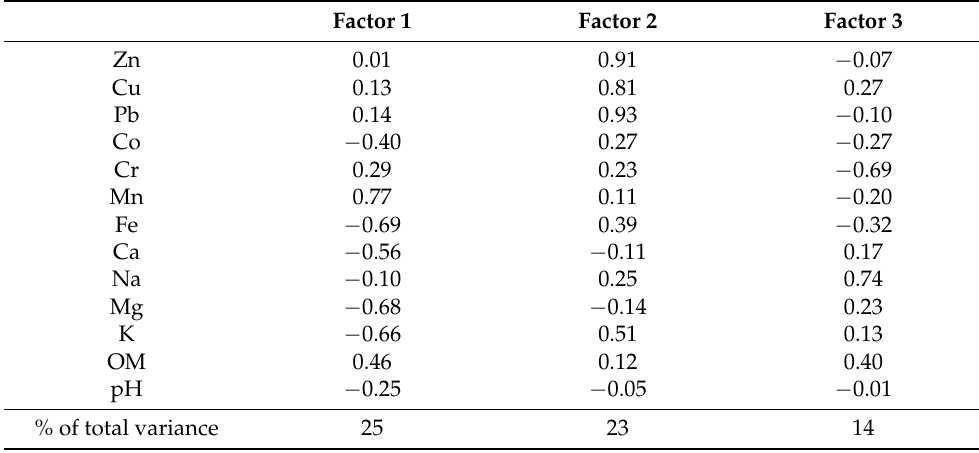
Table 6. Spearman correlation matrix between heavy metal concentrations and sediment properties (pH and